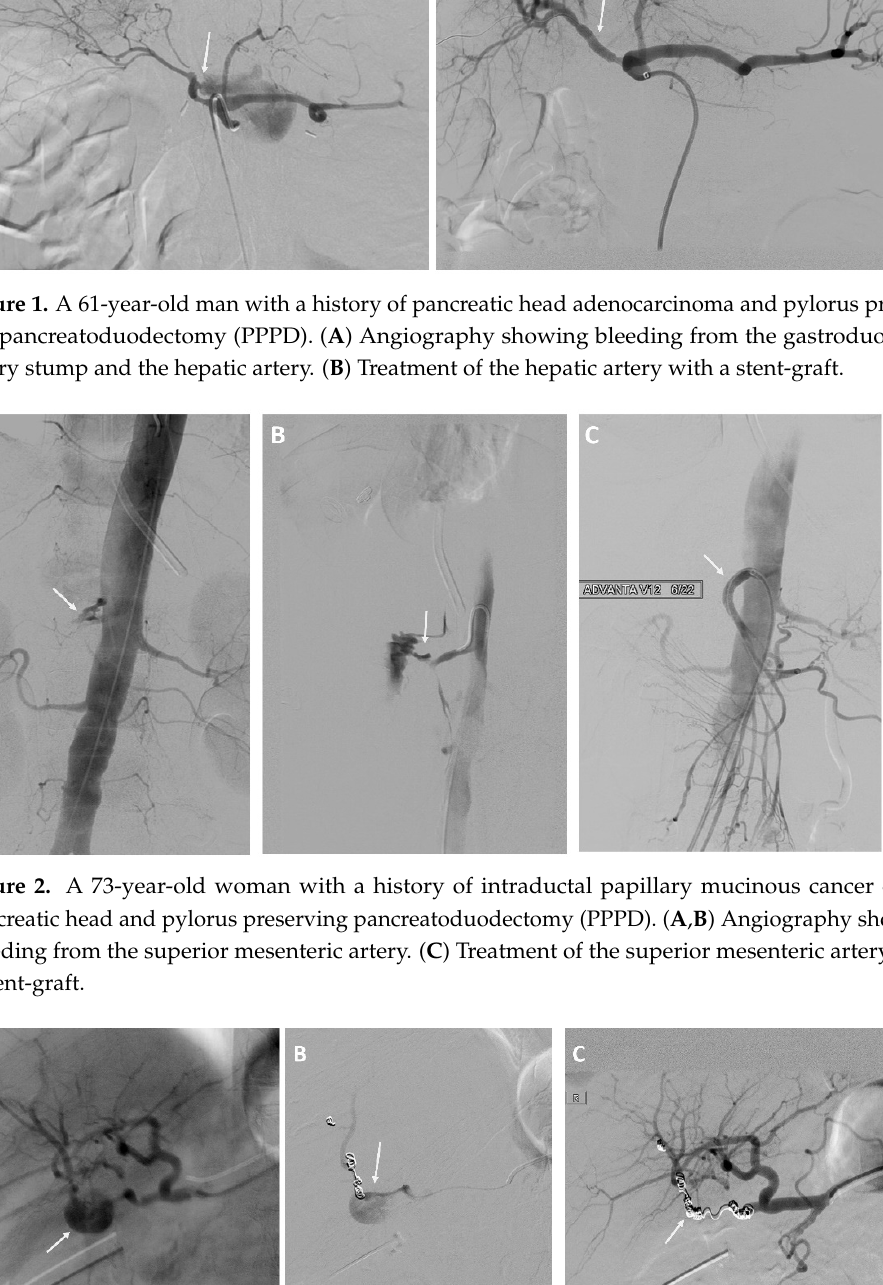
Figure 3. A 74-year-old man with a history of cholangiocarcinoma of the extrahepatic bile ducts treated with resection of the bile ducts and biliodigestive anastomosis. ( A ) Angiography showing bleeding from the right hepatic artery. ( B , C ) Endovascular coil embolization of the right hepatic artery.